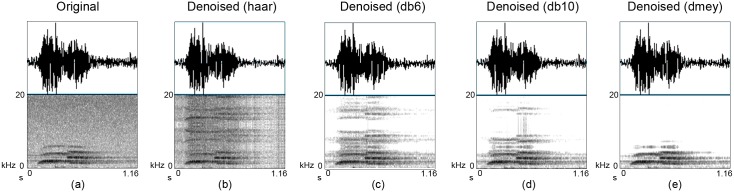
Different mother wavelets produce different results.Same excerpt of a male kiwi whistle (a) original whistle and (b)—(e) denoised with different mother wavelets.